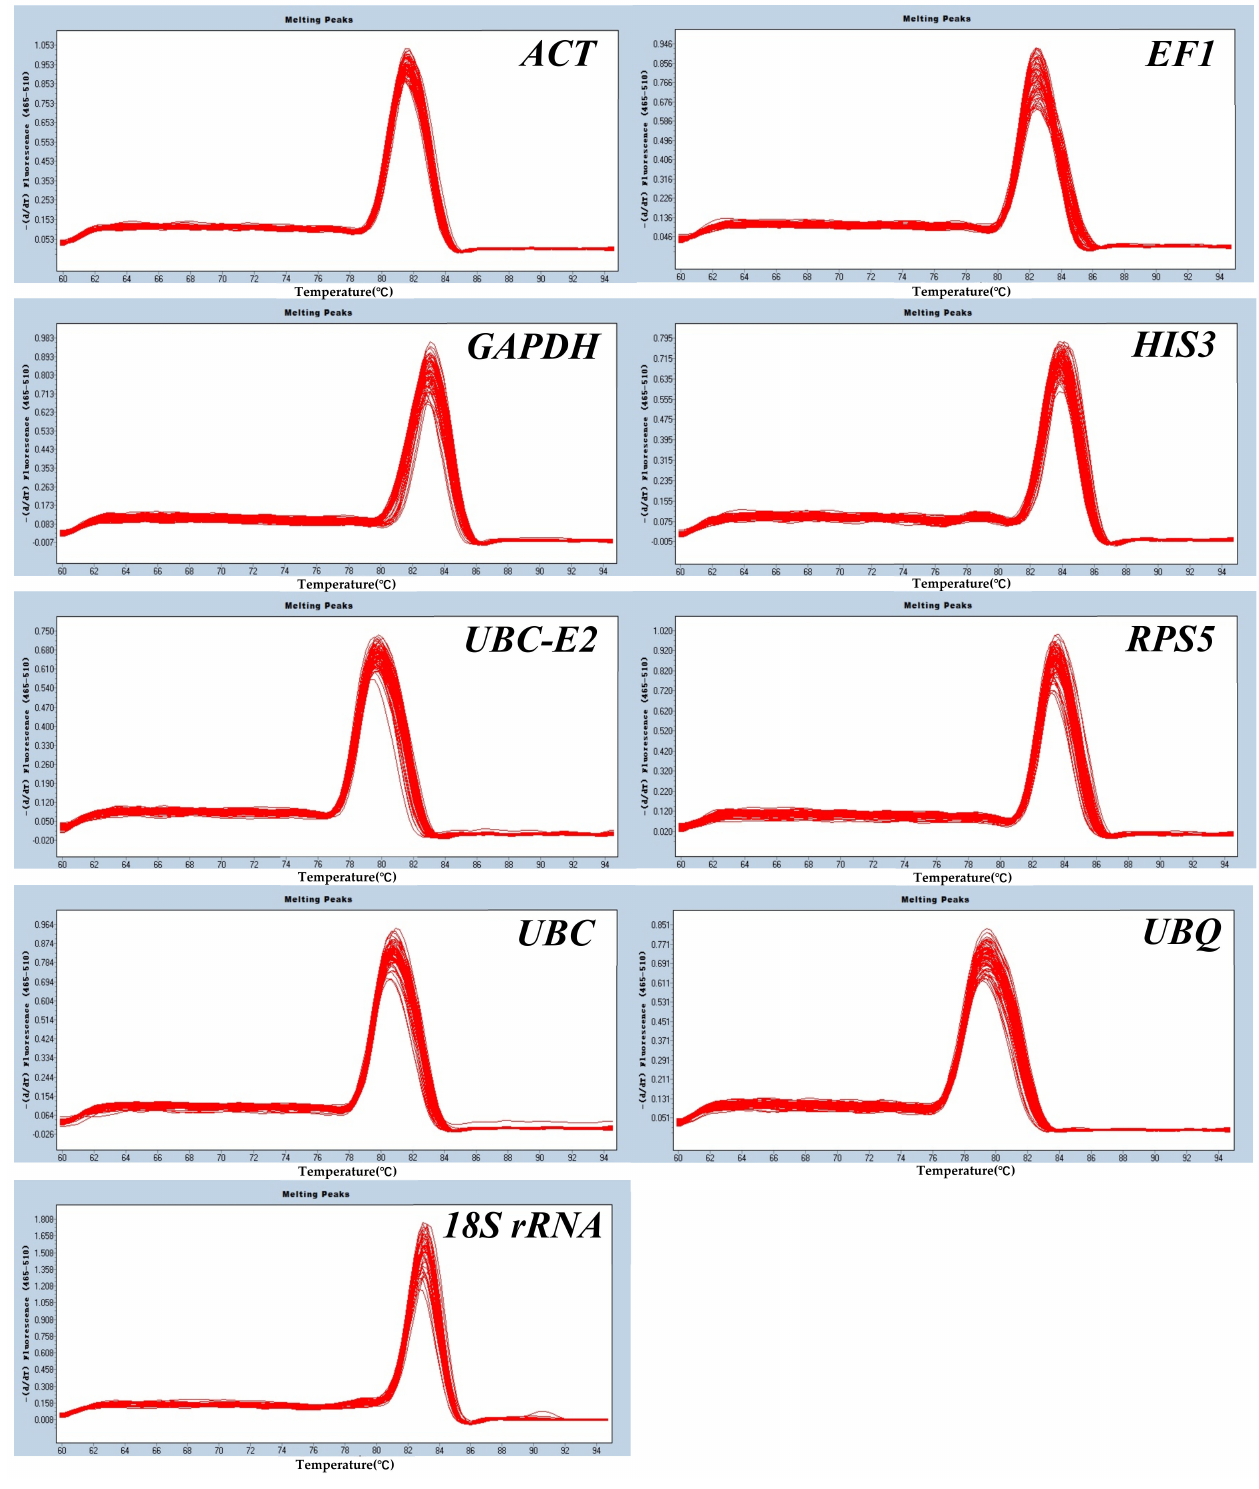
Figure 2. RT − qPCR melting curves of the nine candidate reference genes in